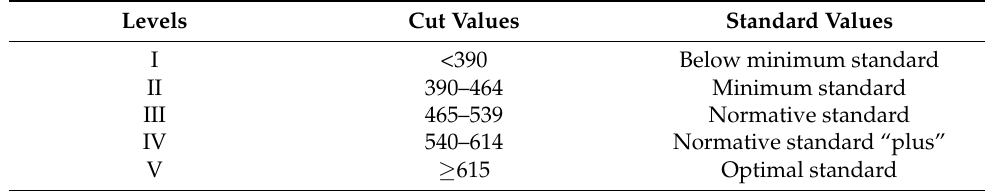
Table 1. Proficiency levels with cut values and standard values of the VERA 3 reading test.